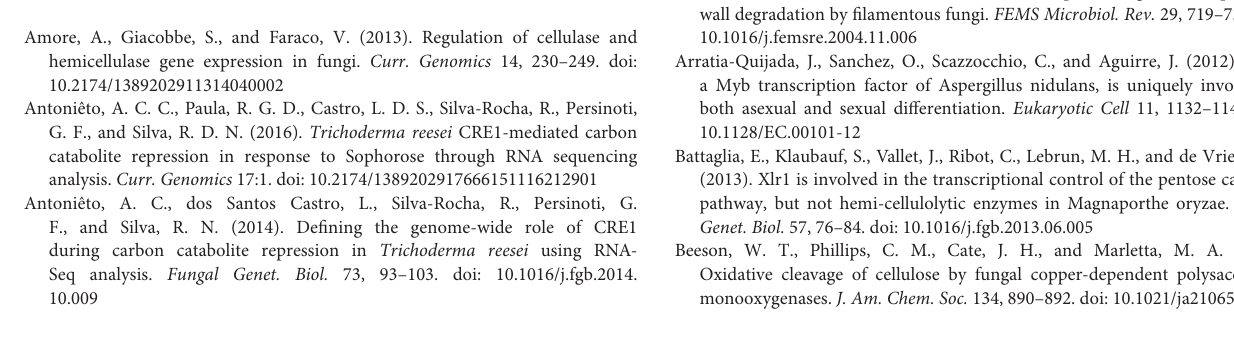
Table S5 | T. reesei CAZymes analyzed in this study. Table S6 | T. reesei CAZymes identified exclusively in cellulose condition. Table S7 | T. reesei CAZymes identified exclusively in sophorose condition. Table S8 | T. reesei CAZymes identified exclusively in glucose condition. Table S9 | Direct regulation by XYR1 on CAZymes identified in each condition studied. Table S10 | Transcriptional factors differentially modulated in each condition studied. Table S11 | Direct regulation by XYR1 in inducing conditions. Table S12 | Transporter genes differentially modulated in each condition